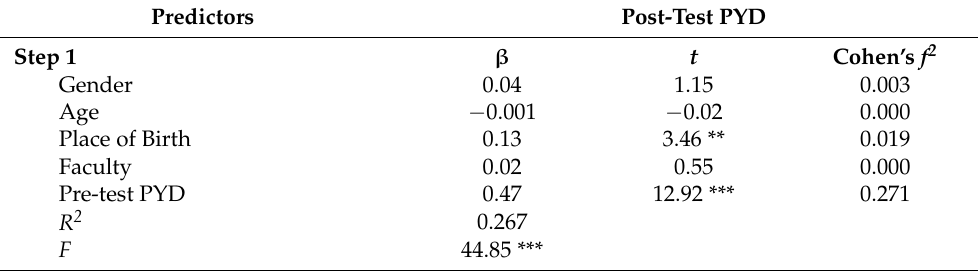
Table 5. Predicting effect of perceived course design, lecturer, and course benefits on post-test PYD after controlling pre-test PYD and demographic